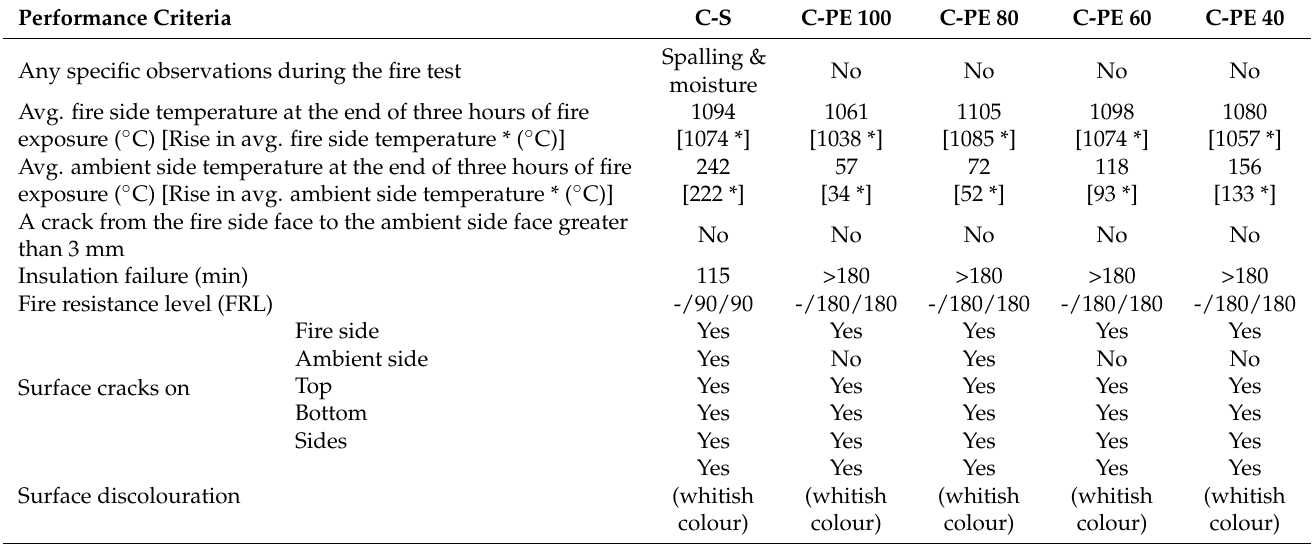
Table 6. Building fire test results for C-S and C-PE blocks.